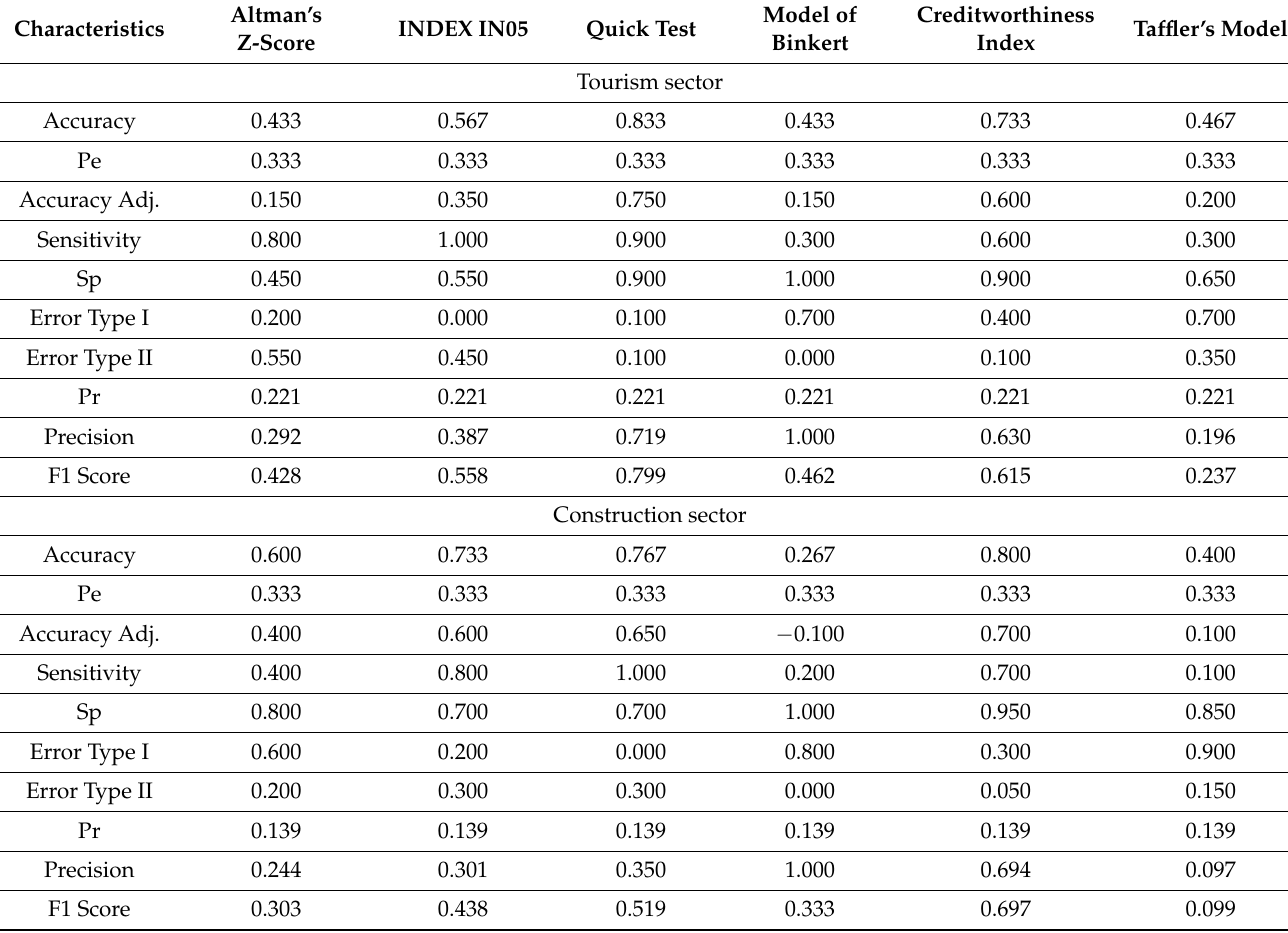
Table A8. Sensitivity and Precision results of globally disseminated models,